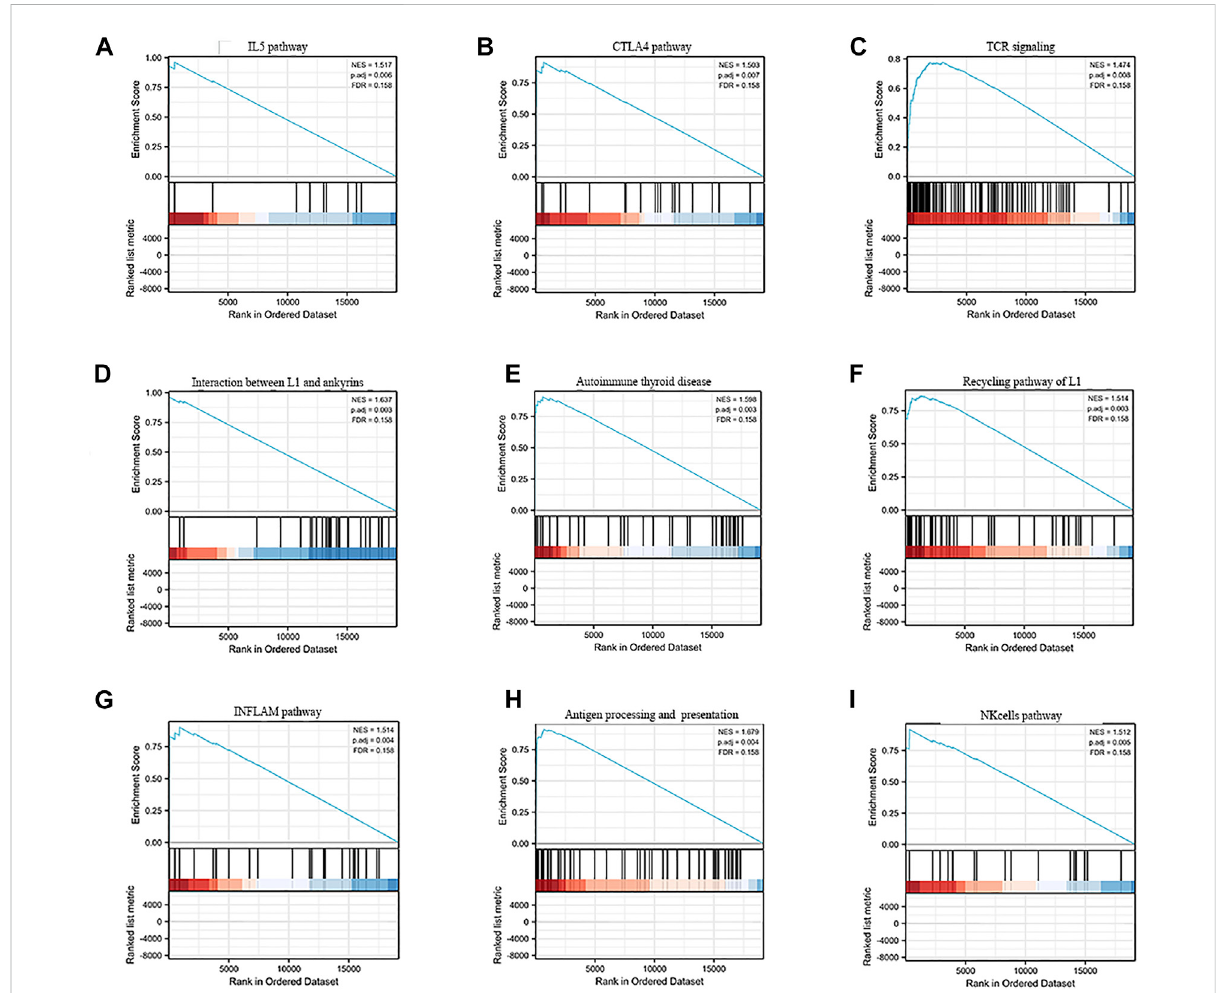
FIGURE 5 GSEA enrichment analysisof the exosome-related lncRNA prognostic signature. (A – I) The nine immune-associated signaling pathways regulatedbythisriskmodel,suchas (A) IL5pathway, (B) CTLA4pathway, (C) TCRsignaling, (D) InteractionbetweenL1andankyrins, (E) Autoimmune thyroid disease, (F) Recycling pathway of L1, (G) INFLAM pathway, (H) Antigen processing and presentation and (I) NK cells